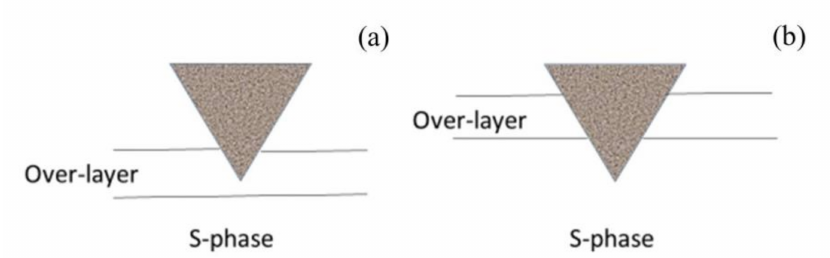
Figure 10. Schematic view of the indenter tip penetrating only the hard over-layer for lower loads ( a ) and also the S-phase for greater loads ( b ). The over-layer thickness resulted to be ~2 µ